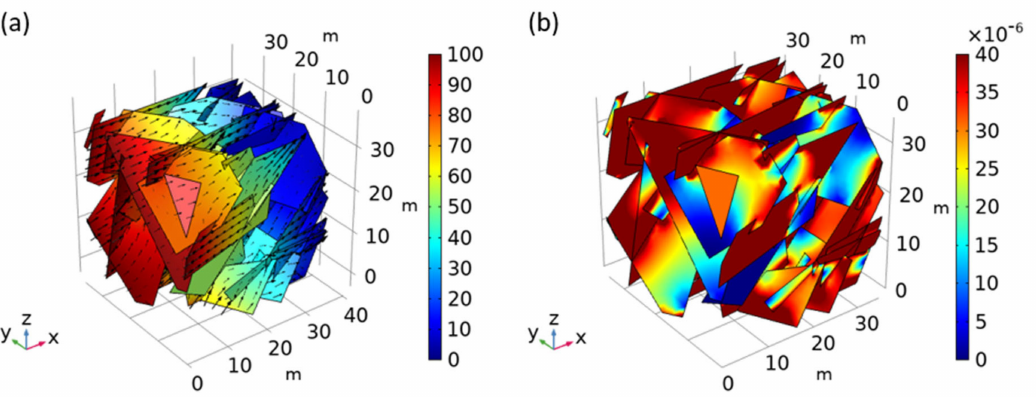
Figure 4. ( a ) Simulated pressure (colour-coded in Pa) and fluid flow velocity field (arrow); ( b ) Magnitude of flow velocity (colour-coded in m/s).